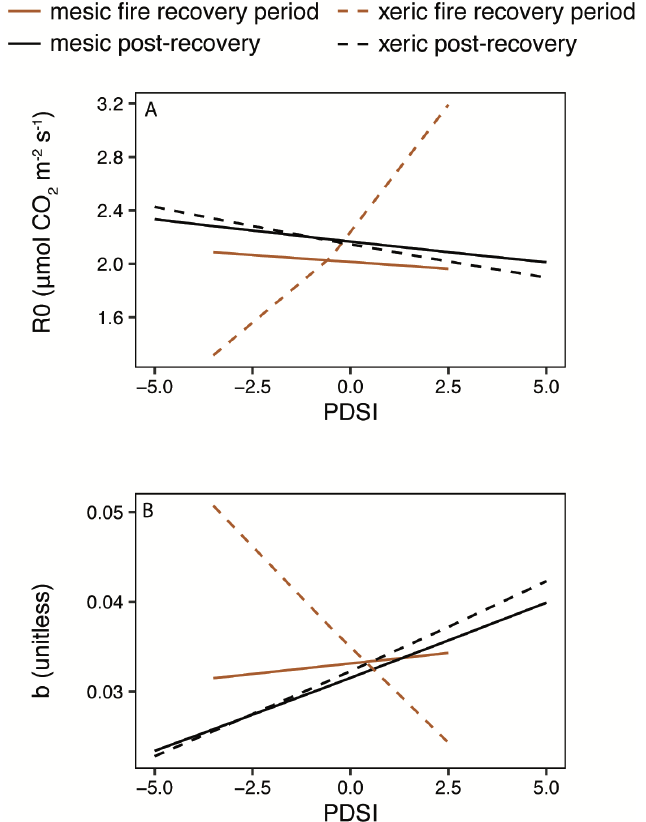
Figure 4. Least square mean estimated temperature response parameter values for fire recovery period and post-recovery by site ( A ) the base respiration rate when air temperature is 0 °C ( R 0 ), and ( B ) the empirical coefficient, b .